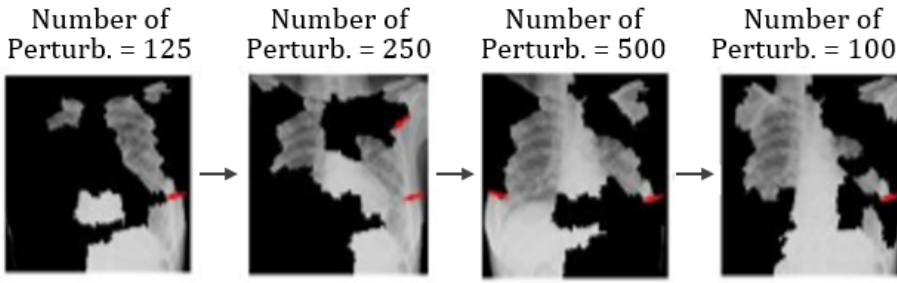
Figure 8. Example of the varying number of features as the number of perturbation